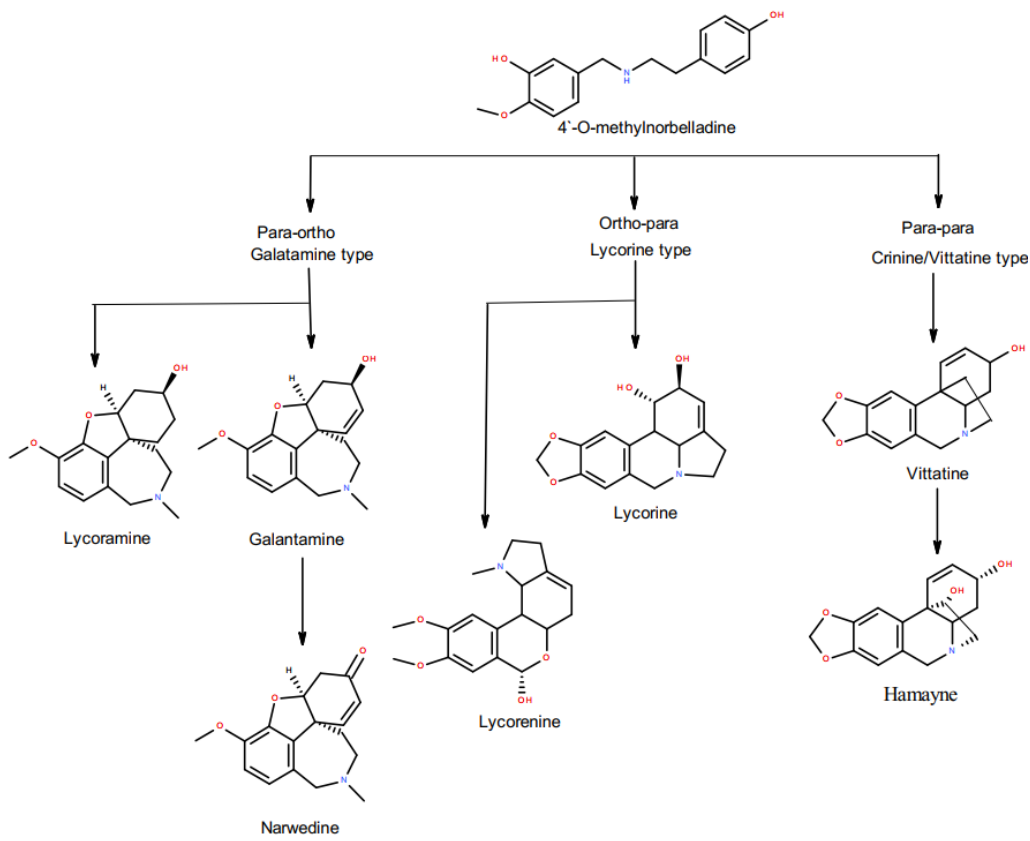
Figure 1. Biosynthetic pathway leading to multiple Amaryllidaceae alkaloids.